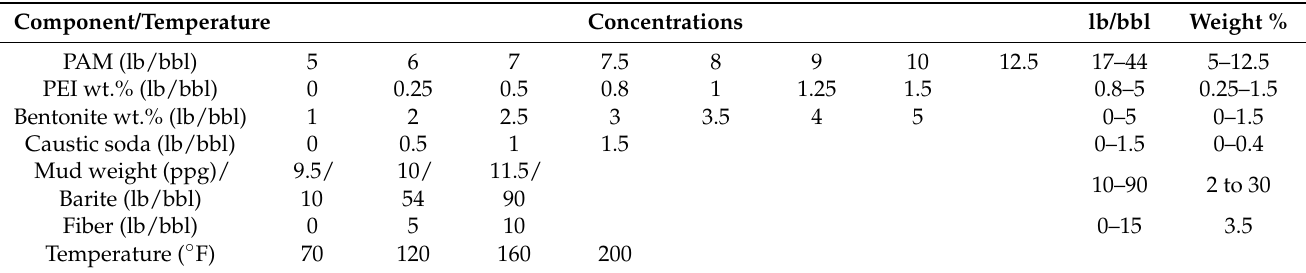
Table 2. Mud component and their range of